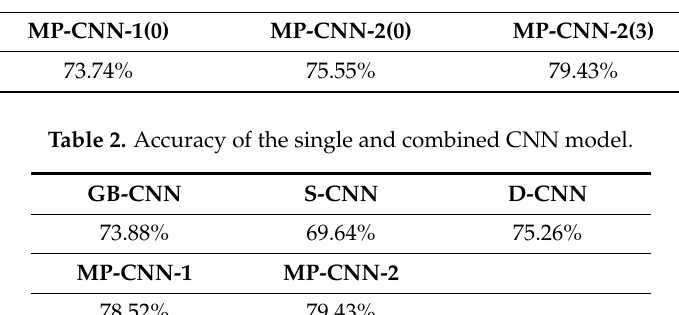
Table 4. Classification accuracy of the Skoda dataset using different methods. We show our result in bold.